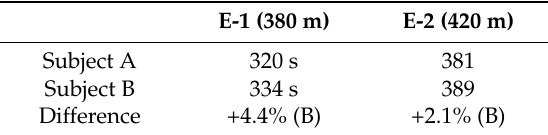
Table 2. Navigational times for the outdoor experiment